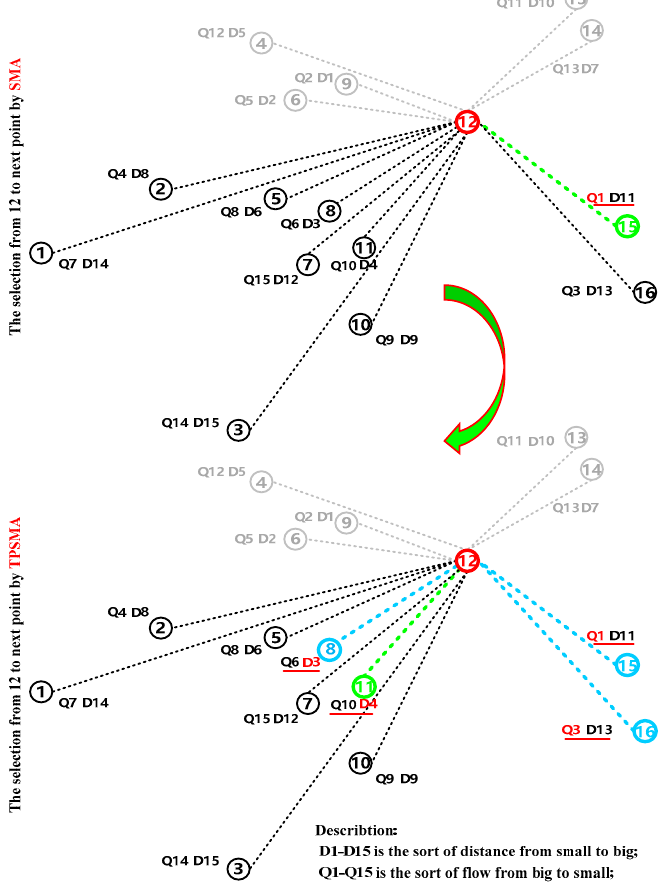
Figure 10. Data of flow and distance from point 12 to the remaining points, and the selection from 12 to the next point by SMA and TPSMA.